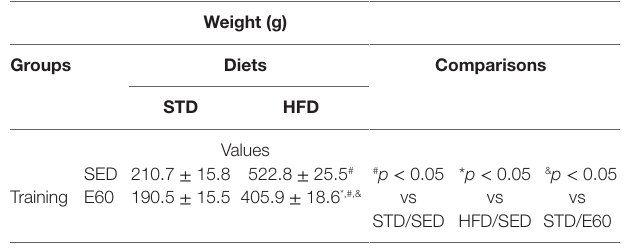
TaBle 1 | Body weight for each experimental